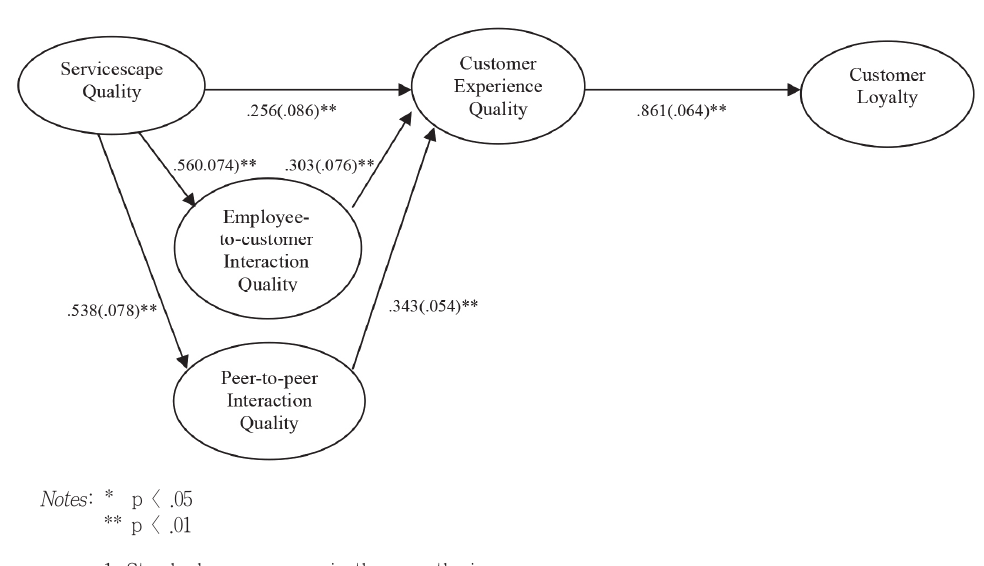
<Figure 2> Structural equation model with the estimated path coefficients and test results